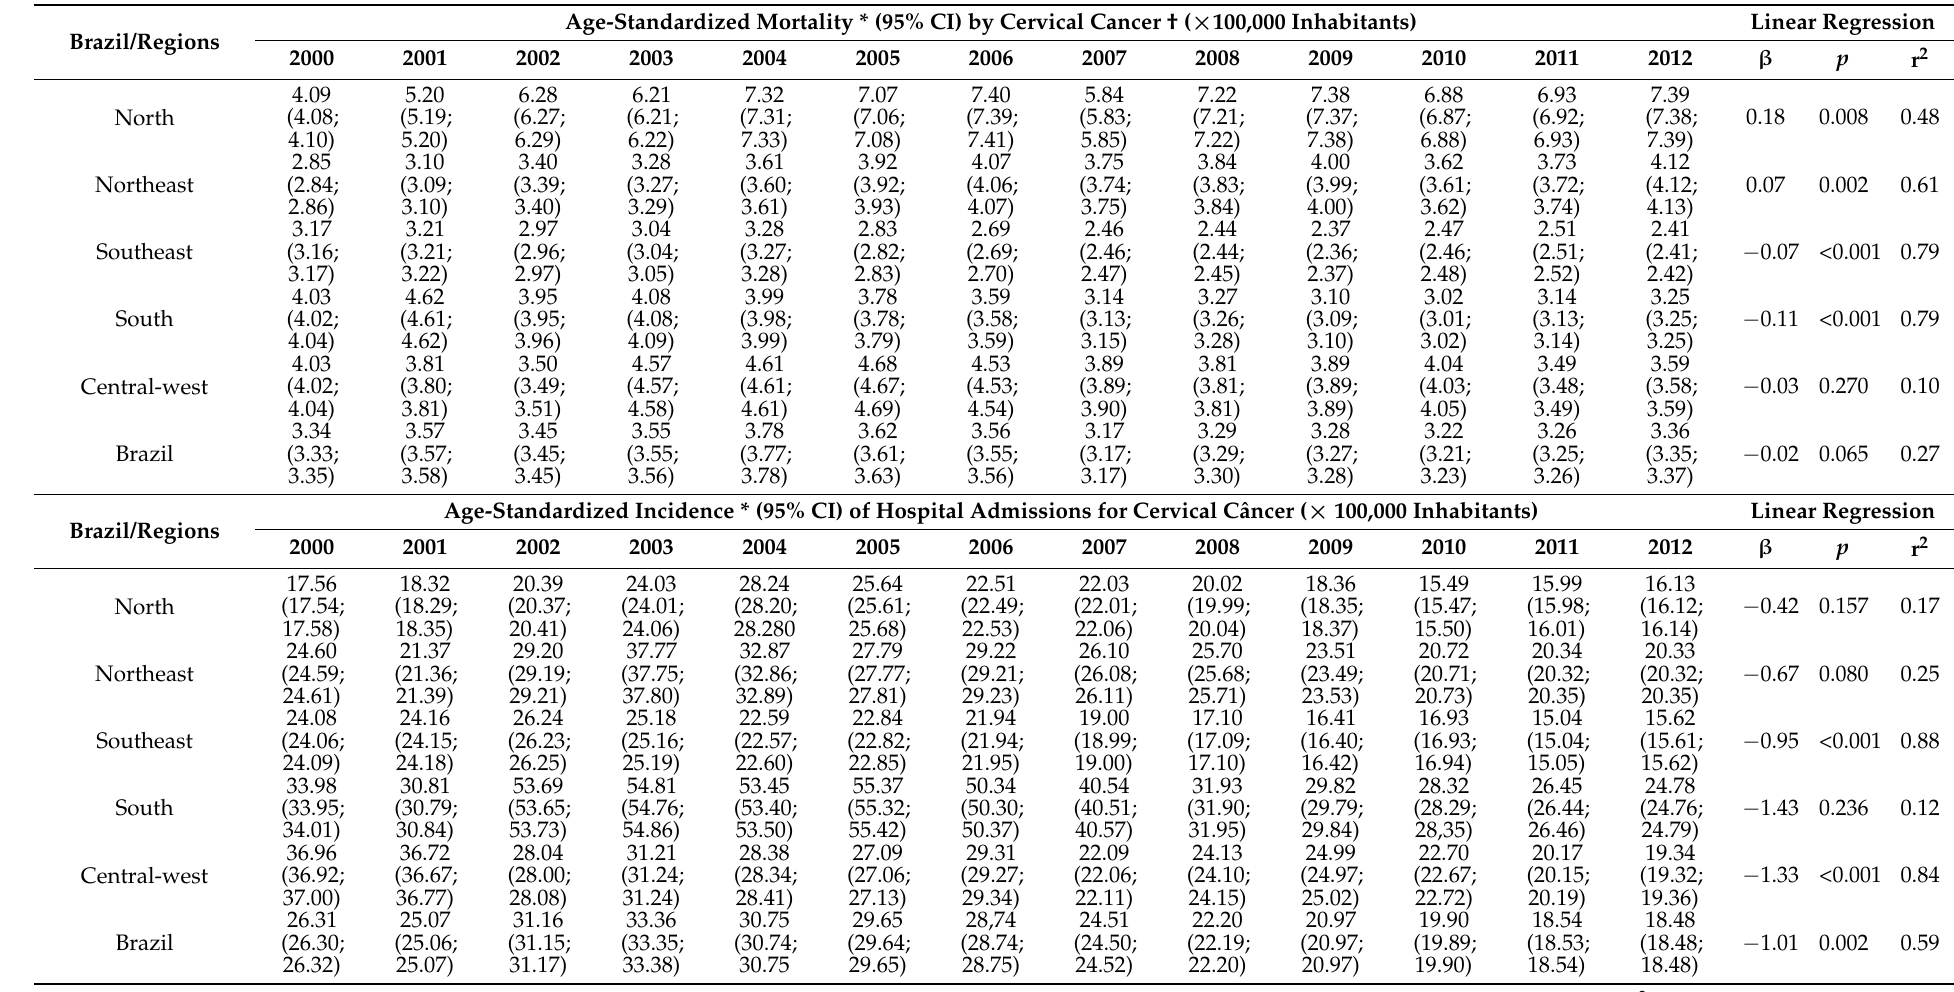
Table 3. Mortality * and incidence * of hospitalization per 100,000 inhabitants (95% confidence interval), and linear regression estimate between 2000 and 2012 according to the regions of the country.